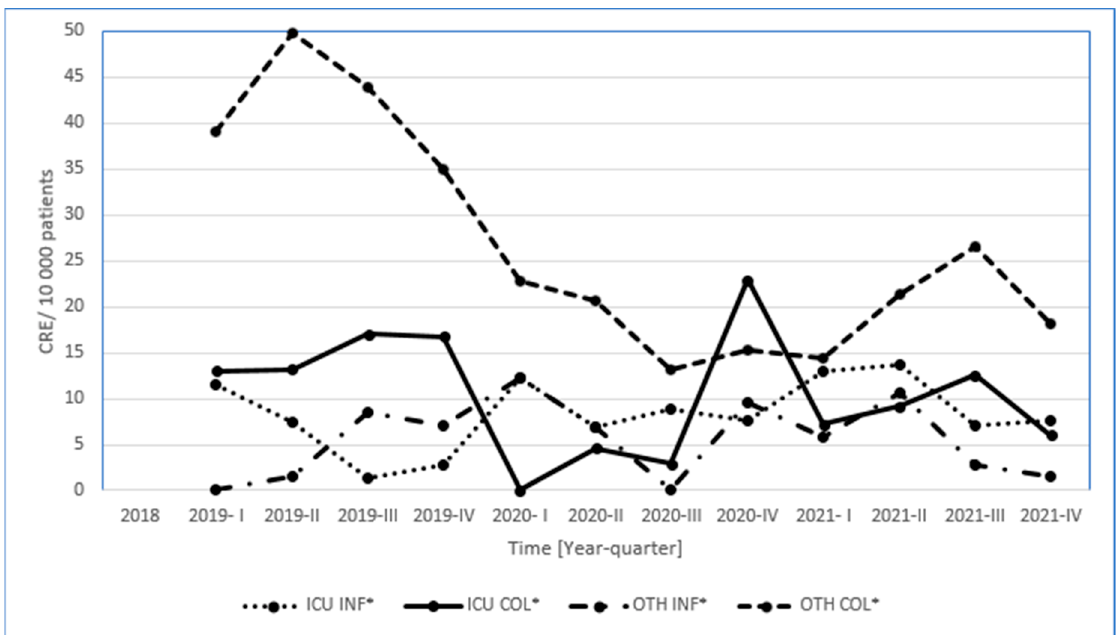
Figure 2. Incidence rate and colonization rate (CRE/10,000 patients) depending on the unit and year of hospitalization (CRE— carbapenem-resistant Enterobacteriaceae , ICU—Intensive Care Unit, INF—infection, COL—colonization, OTH—other units).